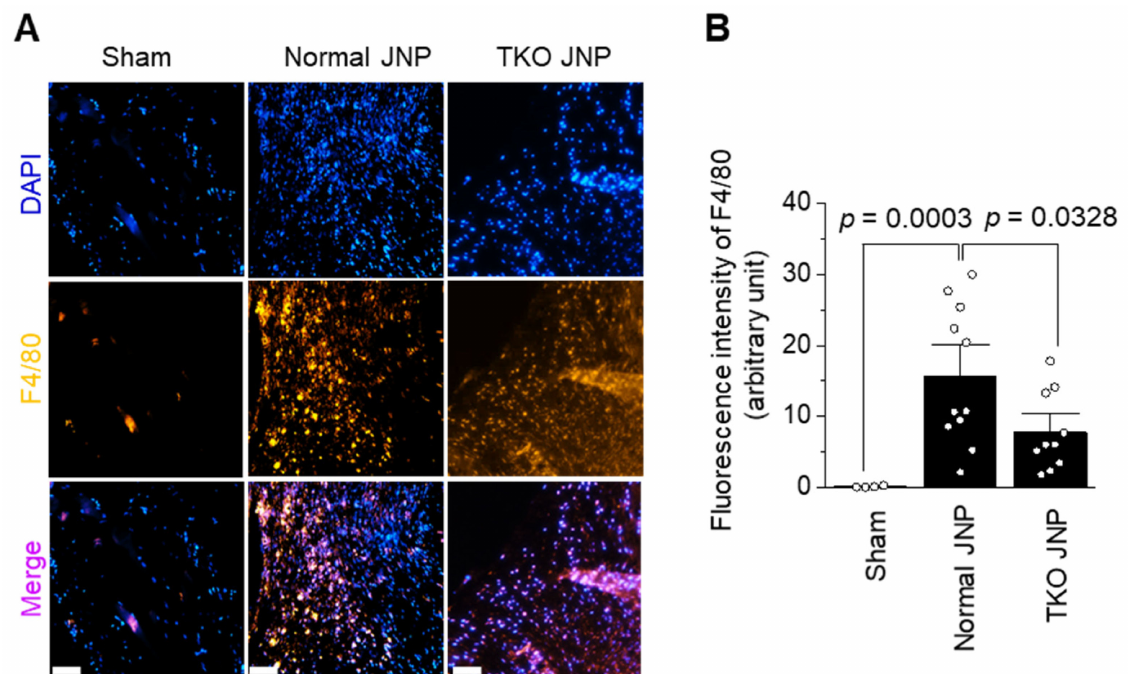
Figure 5. Immunohistochemical analysis of macrophage infiltration in the sham, normal, and TKO JNP groups. The distribution of macrophages was analyzed by anti-F4/80 antibody staining ( A ), and the fluorescence intensity of F4/80 was represented in ( B ). In each field, macrophage counts for the sham ( n = 4), normal ( n = 11), and TKO JNP group ( n = 10) were determined. A two-tailed independent t -test was used for significant analysis. Magnification: 200X. Scale bars: 50 µ m. DAPI (blue for nucleus), F4/80 (Yellow for macrophage), Merge (DAPI +